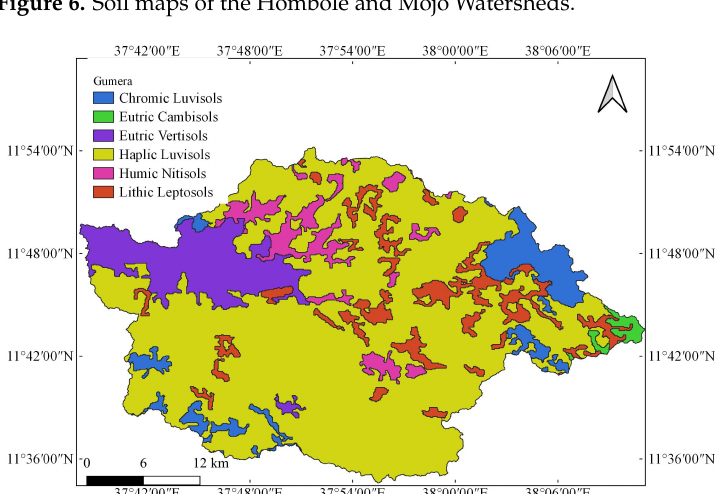
Figure 6. Soil maps of the Hombole and Mojo Watersheds.